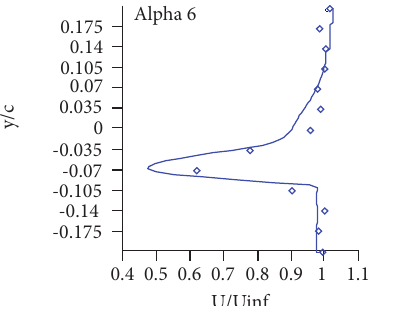
Figure 25. Streamwise velocity profile at x/c = 0.25, Mach = 0.6.